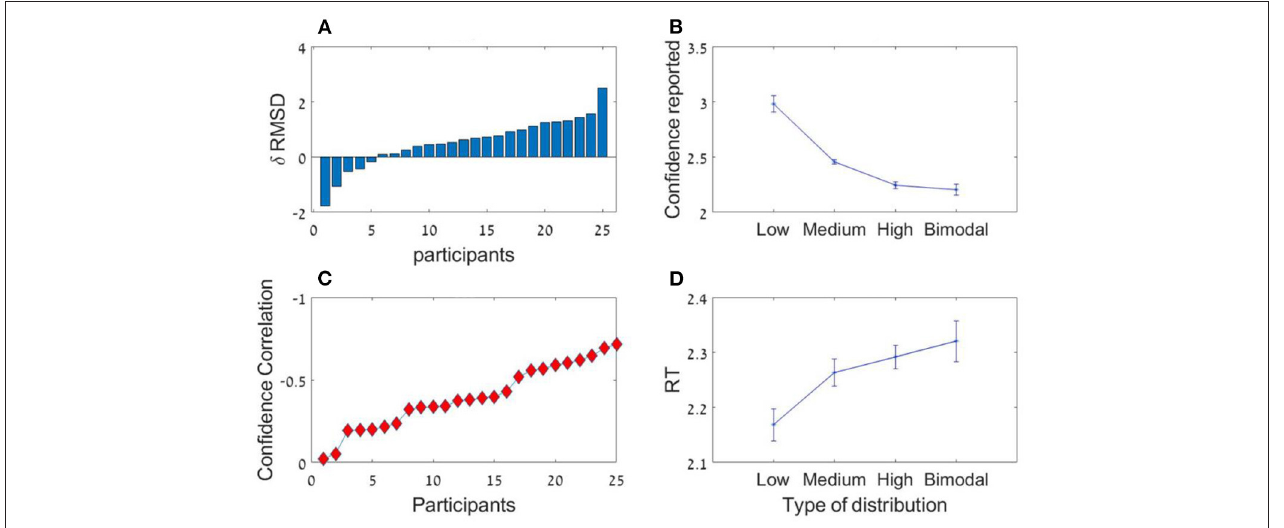
FIGURE 10 | Experiment 3 (A) Individual differences in δ RMSD between the sequence length conditions (positive values indicate improvement in performance as sequence length increases. (B) Confidence reported as a function of variance. (C) Spearman correlations between variance and confidence rate for each participant. (D) RT as a function of